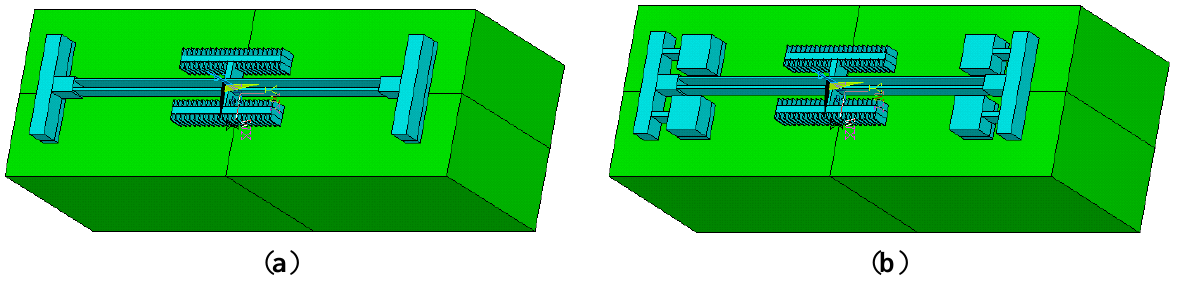
Figure 3. ( a ) Simulation model of the common DETF; ( b ) Simulation model of the improved